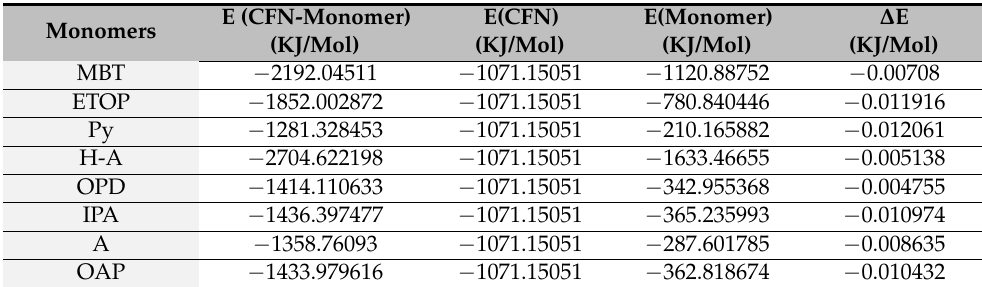
Table 1. Calculating binding energy of CFN and monomers using DFT model at B3LYP level. E Monomers